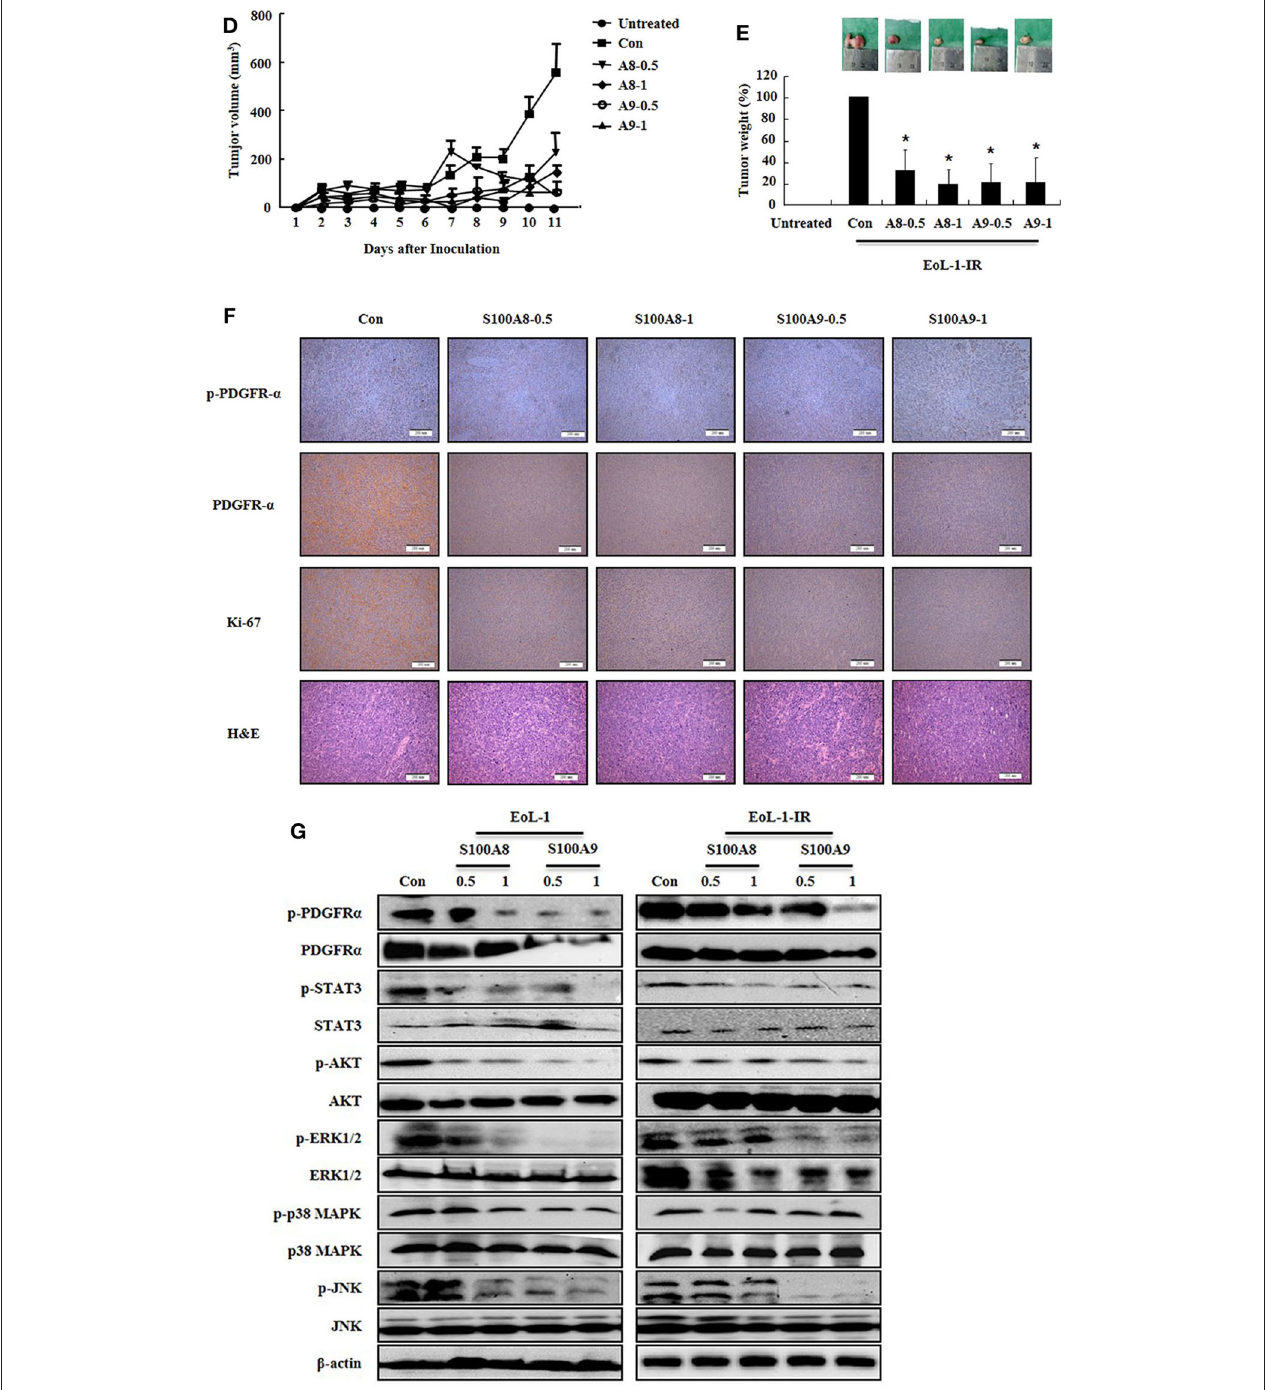
FIGURE 5 | S100A8 and S100A9 suppress tumorigenesis induced by xenograft of EoL-1 and EoL-1-1R in NOD-SCID mice. (A–F) Five-week-old female NOD-SCID (NOD.CB17-Prkdcscid/J) mice were divided into six groups ( n = 5 per a group) as described in the materials and methods: untreated, control, S100A8 treatment (0.5 and 1mg doses), and S100A9 treatment (0.5 and 1mg doses). The control, S100A8 treatment, and S1009 treatment groups were subcutaneously inoculated in the shoulder with EoL-1 cells (2 × 10 7 /100 µ L) (A–C) or EoL-1-IR cells (1 × 10 7 /100 µ L) (D–F) . Treatment groups were subsequently administered subcutaneous doses of 0.5 or 1mg S100A8 or S100A9 at days 5 and 7 after cell inoculation. The untreated group was injected with vehicle (PBS). Tumor volume (day 1–11) and tumor weight (day 11) were measured (A,B,D,E) . Tumor mass was examined for detecting phospho-PDGFR α , PDGFR α , and Ki-67, applying immunohistochemistry and hematoxylin and eosin stain (Scale bar: 200 µ m) (C,F) , or subjected to Western blotting to determine phosphorylation and nonphosphorylation of PDGFR α , STAT3, AKT, ERK1/2, p38 MAPK, and JNK (G) . β -actin was used as the internal control. * p < 0.05 indicates a significant difference between the control and stimulator-treated